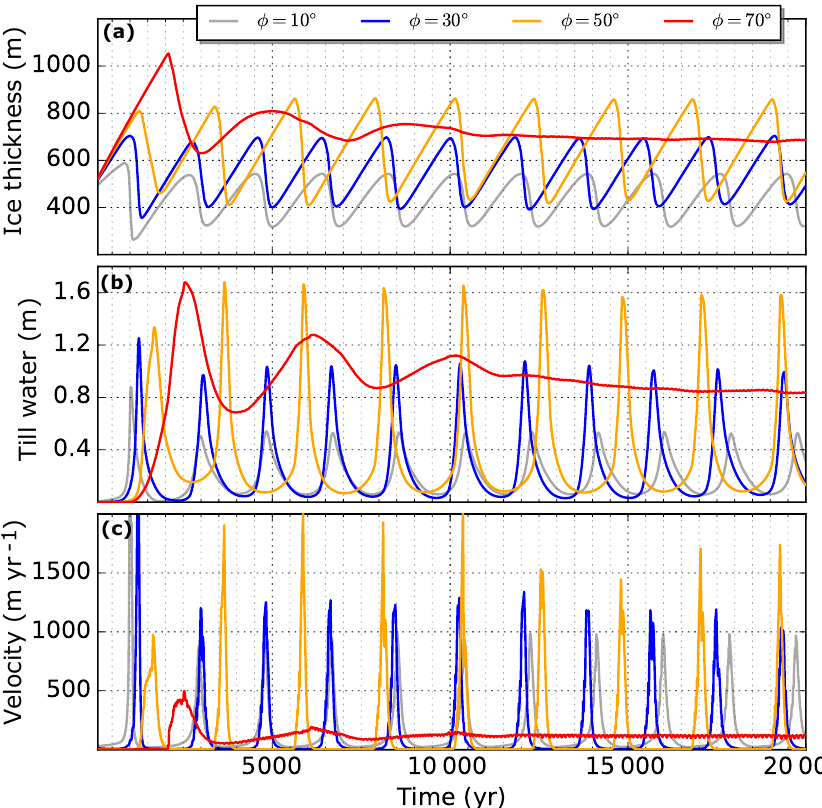
Figure 7. Time series analogous to Fig. 6, here for φ ≥ 10 ◦ . For relatively large values of φ there is a transition from maintained cyclic surging to damped